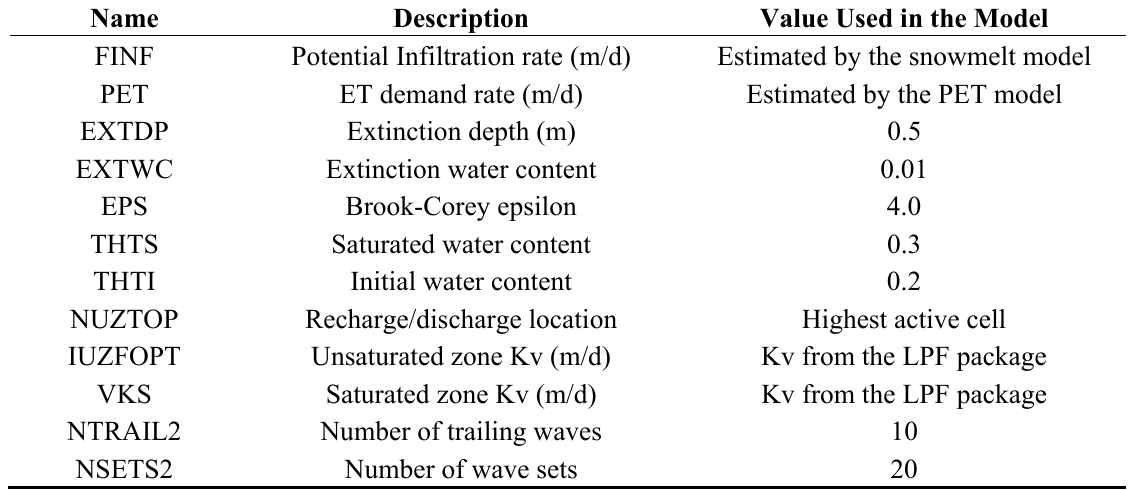
Table 1. UZF1 and MODFLOW-2005 parameter used in the